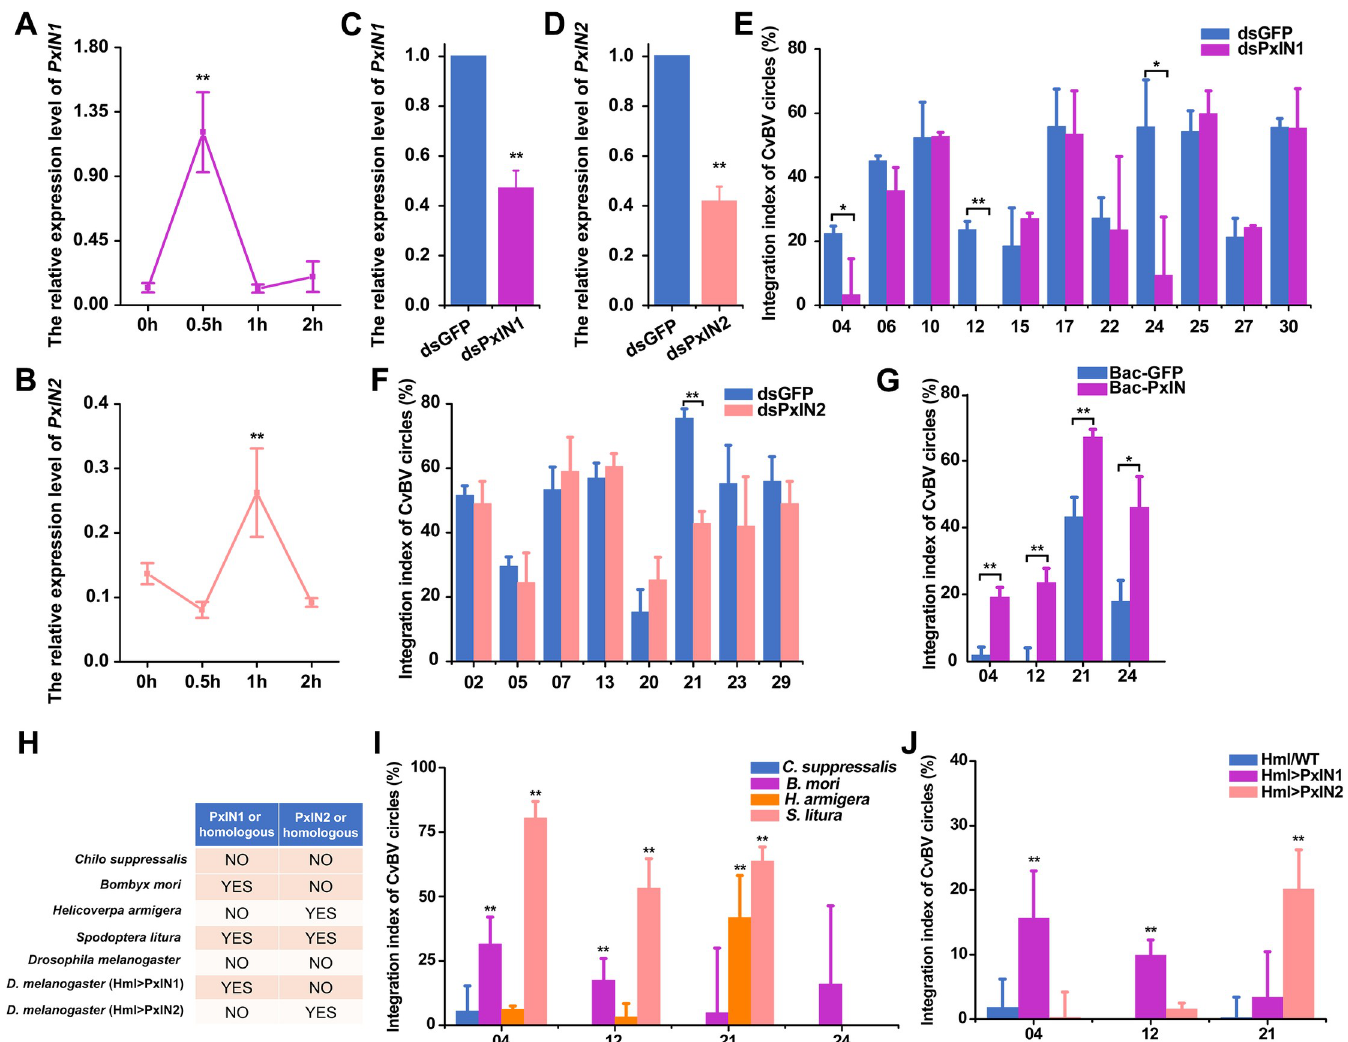
Fig 5. PxIN1 and PxIN2 are essential for CvBV integration. A and B : The transcript levels of host PxIN1 and PxIN2 at the early parasitization stage, respectively. C and D : RNA interference efficiency of host PxIN1 and PxIN2 , respectively. E : The integration indices of EICs at 30 min p.p after interference of PxIN1 . F : The integration of MICs at 1 h p.p (CvBV_02, 05, 20, 23 and 29) and LICs at 2 h p.p (CvBV_07, 13 and 21) after interference of PxIN2 . G : The integration indices of CvBV_04, 12, 21, and 24 after the interference of PxIN1 and PxIN2 . Bac-PxIN means that PxIN1 and PxIN2 were rescued by baculoviruses. The integration indices of CvBV_04, 12, and 24 were detected at 30 min p.p. The decreased integration indices of CvBV_21 were detected at 2 h p.p. H : The distribution of PxIN1 , PxIN2 and their homologues in CvBV non-adaptive hosts and ectopic expression PxIN1 and PxIN2 in D . melanogaster . I and J : Detection of the integration indices of CvBV_04, 12, 21 and 24 into genomes of non-adaptive caterpillar hosts (i), and flies that ectopically expressed PxIN1 and PxIN2 (j). One-way ANOVA followed by Tukey’s multiple comparison test for D, G, E, H and I. Error bars indicate ± SD, �� p < 0.01, � p < 0.05. versus C . vestalis infected host hemocytes, and found 1747 genes were upregulated and 1629 genes were downregulated (S11A Fig). Gene ontology enrichment analysis showed that there were 22 genes associated with DNA integration (15 up, 7 down), and KEGG enrichment analy- sis revealed 45 genes involved in DNA repair (9 up, 36 down) (S6 Table, S3 and S4 Data). Fur- thermore, we analyzed the transcriptional dynamics of the 15 up-regulated genes associated with DNA integration in P . xylostella (S11B Fig). Interestingly, we observed that transcrip- tional upregulation of two genes was timely correlated with the integration kinetics of CBCs, respectively: one gene increased rapidly at 30 min p.p (Fig 5A) and the other increased